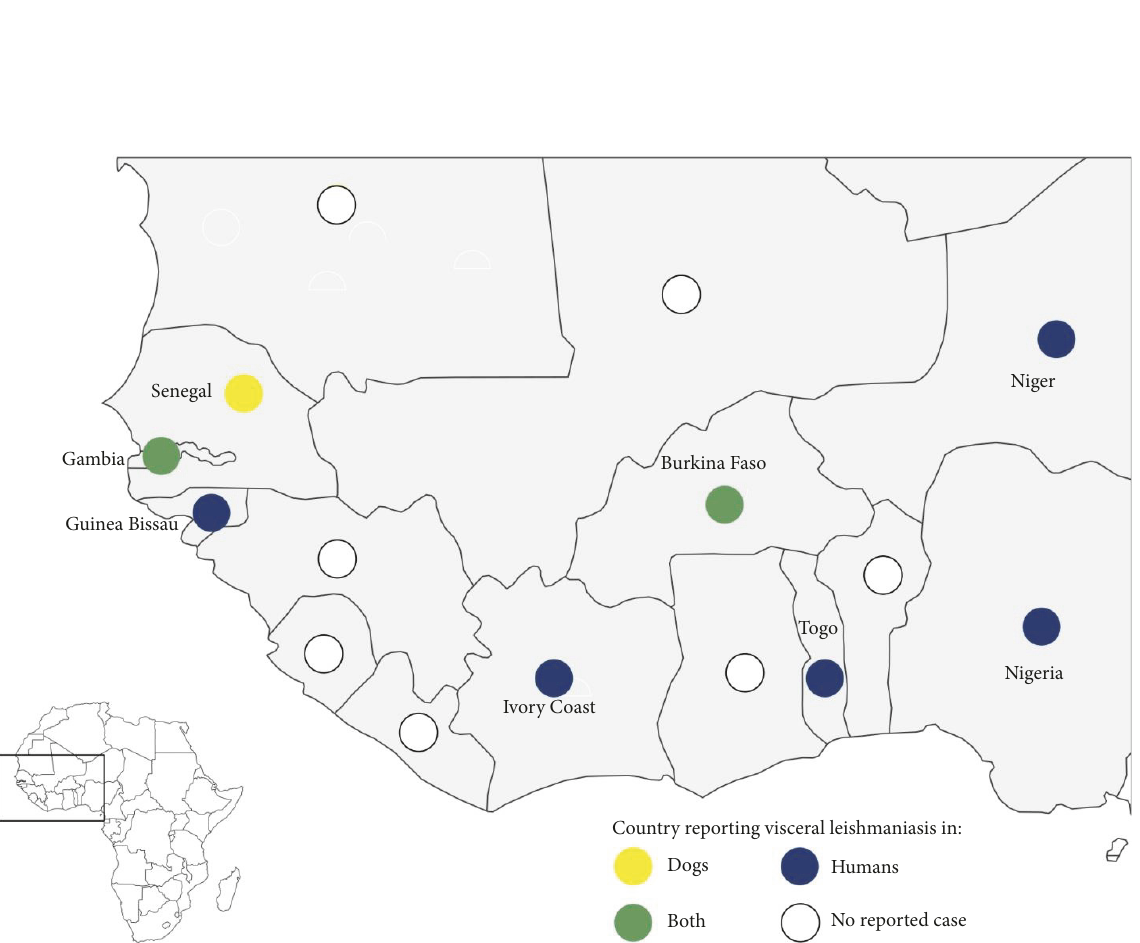
Figure 1: Geographic distribution of CVL and HVL in West Africa 1949-2018 (made with Philcarto,